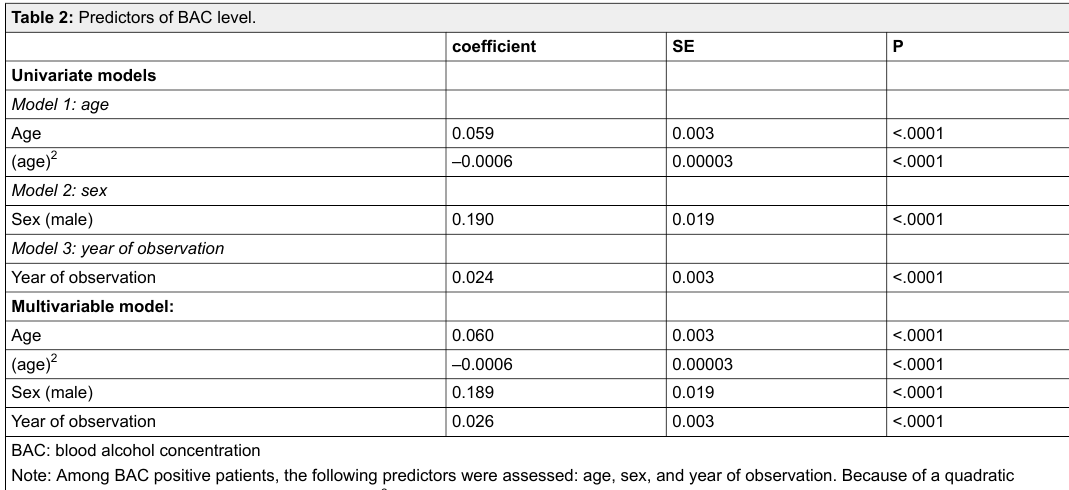
Table 2: Predictors of BAC